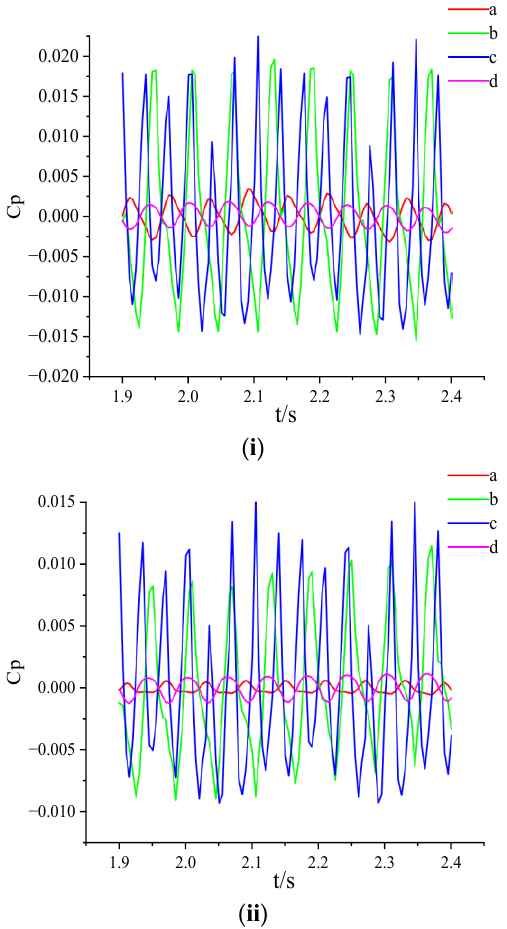
Figure 10. Time – domain diagram of the pressure pulsation under turbine conditions. ( ⅰ ) 0.6Q. ( ⅱ ) Figure 10. Time–domain diagram of the pressure pulsation under turbine conditions. ( i ) 0.6Q. ( ii ) 1.0Q.